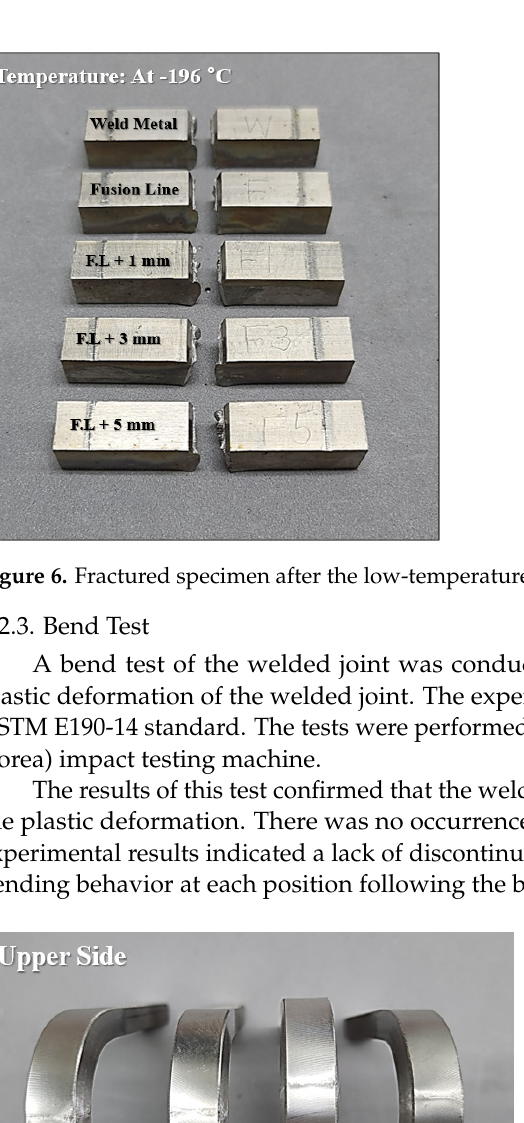
11 of 15 Figure 5. Results of the tensile test and the shape of the fracture specimen. ( a ) Yield-tensile strength of the laser-MIG hybrid welded joints, ( b ) shape of the fracture specimen after the tensile test. 3.2.2. Low-Temperature Impact Test Low-temperature impact tests must be conducted on the material specimen to test the viability of using the material for constructing LNG fuel tanks. The IGC Code states that the test should require more than 27 J of energy for a weld metal at − 196 °C. The low- temperature impact tests were performed according to the guidelines specified by ASTM E23-16b. The tests were performed using a Tinius Olsen/201892 (Horsham, PA, USA) im- pact testing machine. An impact value greater than or equal to 58 J was obtained for each location of the specimen through the experiment. Table 6 lists the low-temperature impact values of each specimen location. The fractured surface is shown in Figure 6. Table 6. Low-temperature impact values for different specimen locations. Position